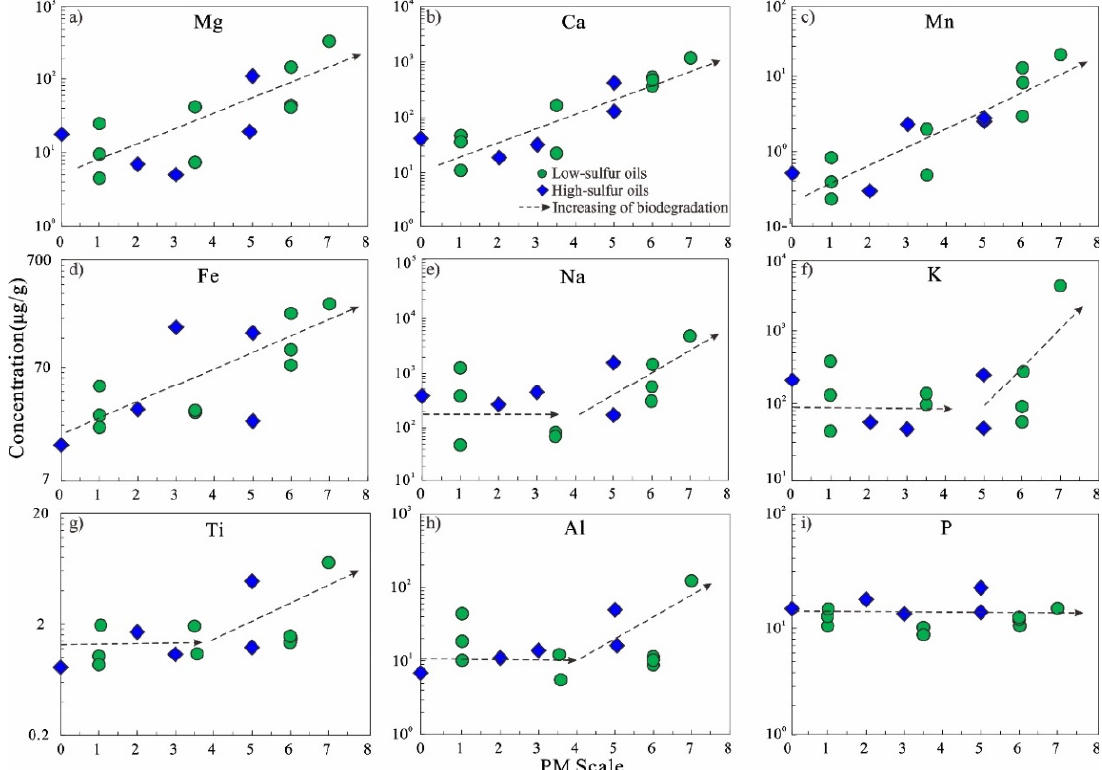
Figure 8. Cross plots showing differential enrichment of major elements based on increasing biodegradation levels (PM scale). ( a ) Cross plot of PM Scale versus Mg; ( b ) Cross plot of PM Scale versus Ca; ( c ) Cross plot of PM Scale versus Mn; ( d ) Cross plot of PM Scale versus Fe; ( e ) Cross plot of PM Scale versus Na; ( f ) Cross plot of PM Scale versus K; ( g ) Cross plot of PM Scale versus Ti; ( h ) Cross plot of PM Scale versus Al; ( i ) Cross plot of PM Scale versus